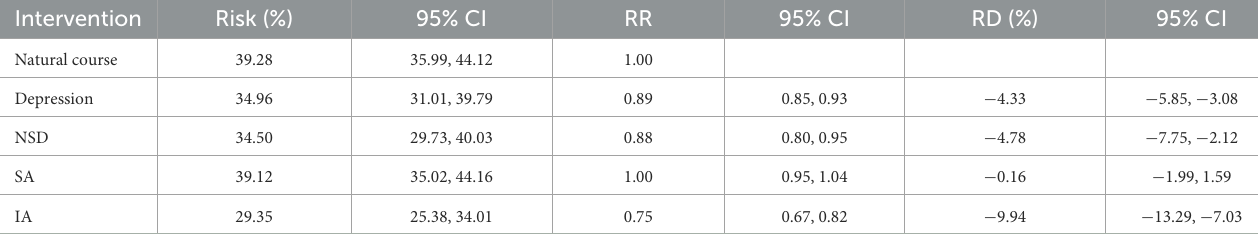
TABLE 3 Cognitive impairment risks at 7-year follow-up under natural course and joint hypothetical interventions. Intervention Natural course